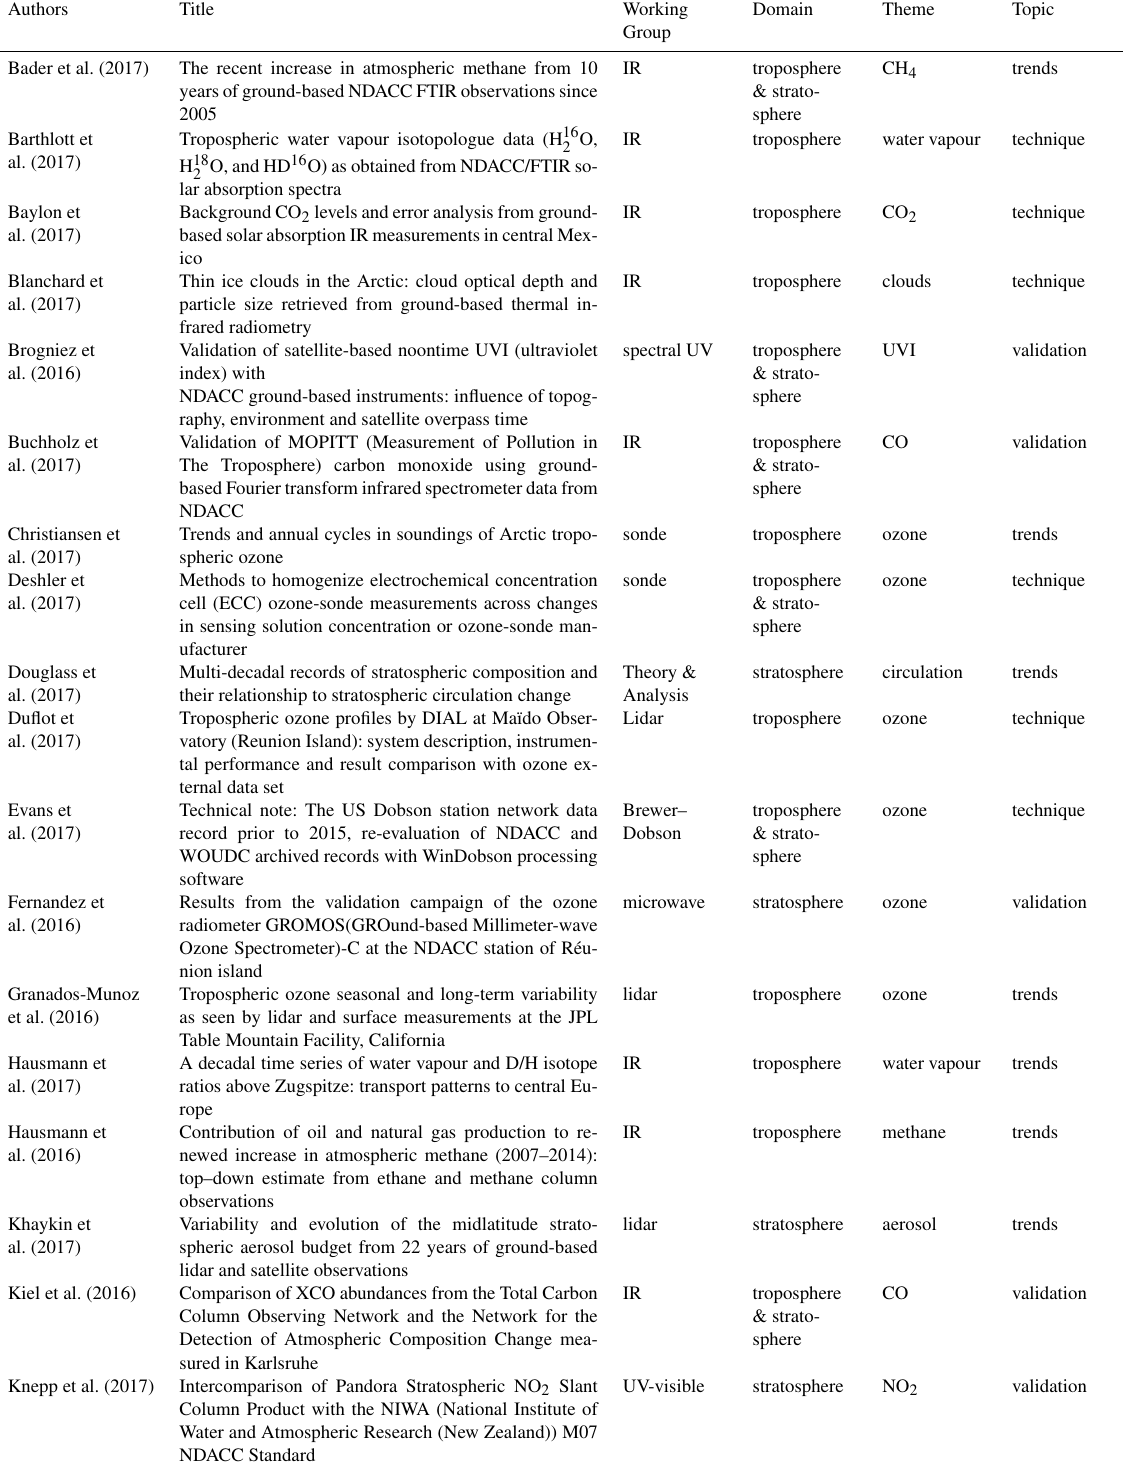
Table A1. Inventory of papers in this special issue, categorized by atmospheric domain, theme (main species addressed) and topic.